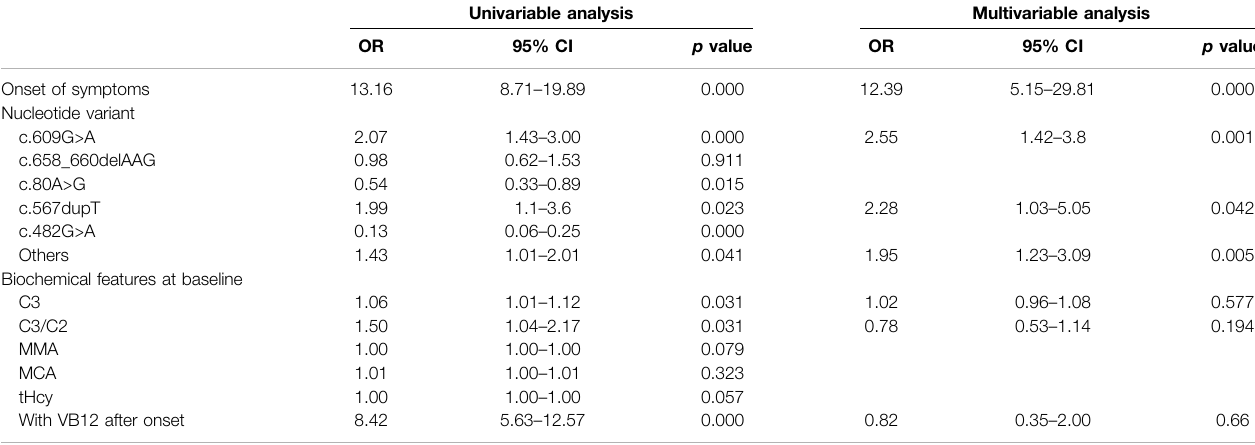
TABLE 3 | Univariate and multivariate analysis of predictors for poor outcome.